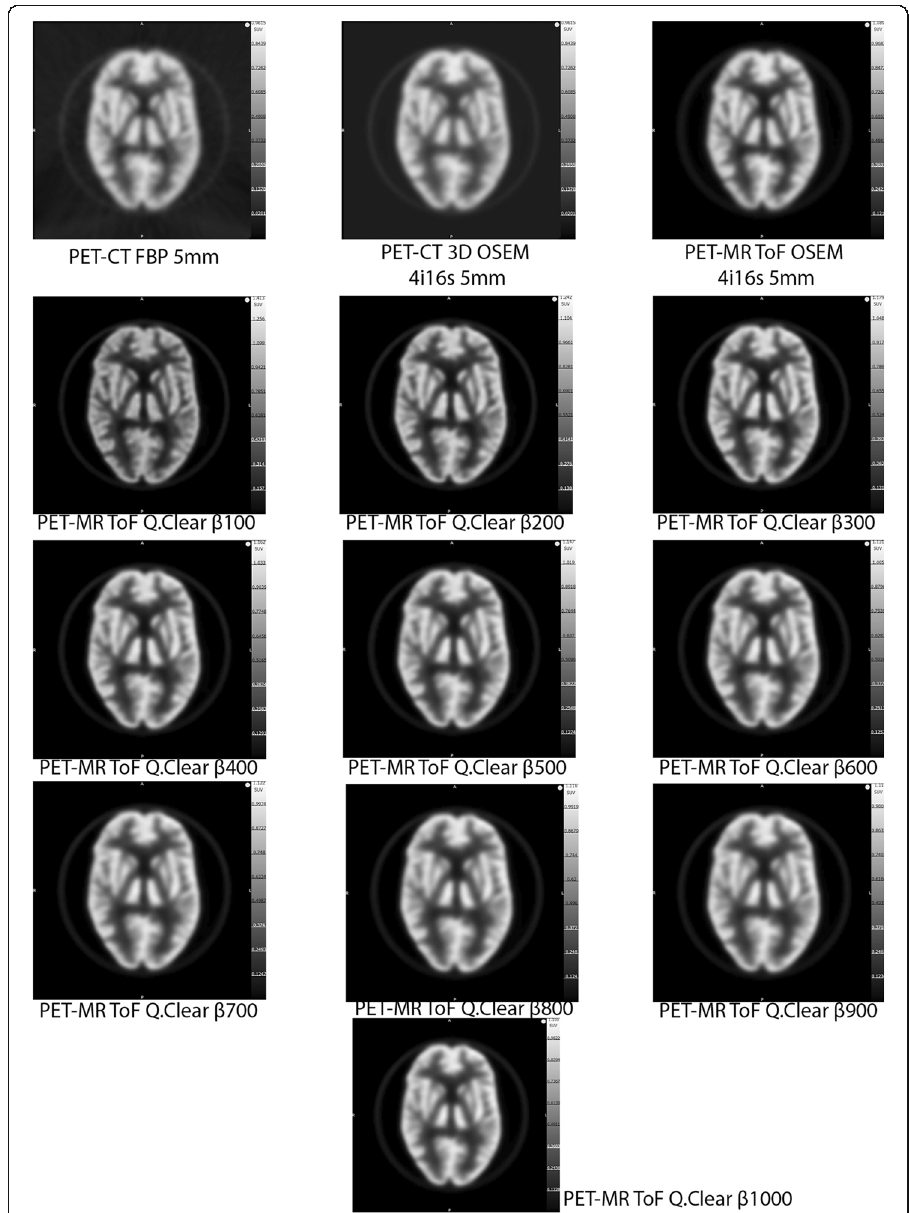
Fig. 3 Hoffman phantom filled with 18 F-BCPP in the PET-CT and PET-MR. FBP and 3D OSEM 4 iterations, 16 subsets, 5 mm filter obtained in the PET-CT are displayed. TOF OSEM 4 iterations, 16 subsets, 5 mm filter and TOF Q.Clear β 100 to 1000 obtained in the PET-MR are also displayed. Note the visual differences in image quality for the Q.Clear reconstructions as β